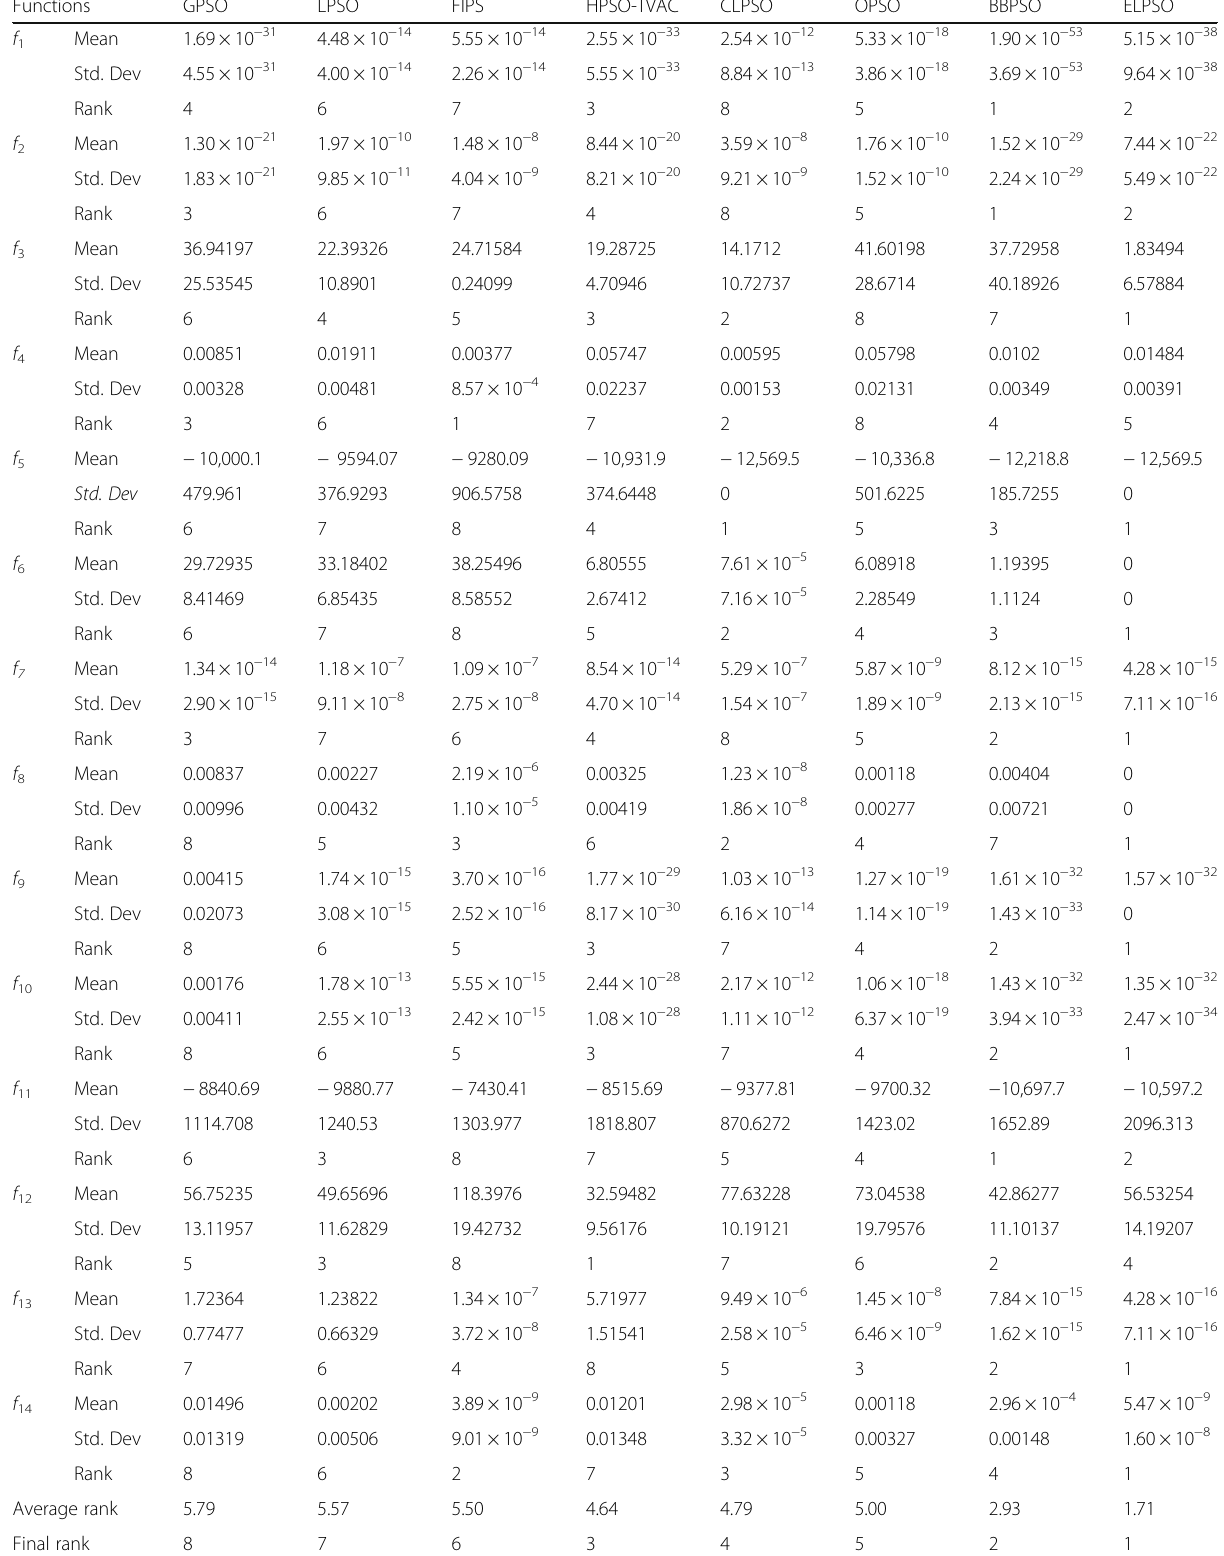
Table 3 Performance for ELPSO and other